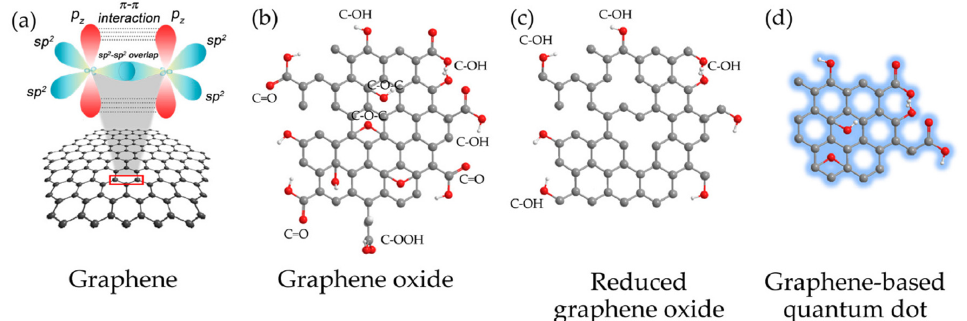
Figure 1. CBM: ( a ) Graphene with sp 2 -hybridized carbon atoms; ( b ) GO; ( c ) r-GO and ( d ) GQD. Reproduced from Ref. [50] with permission from MDPI. Copyright 2017 MDPI.